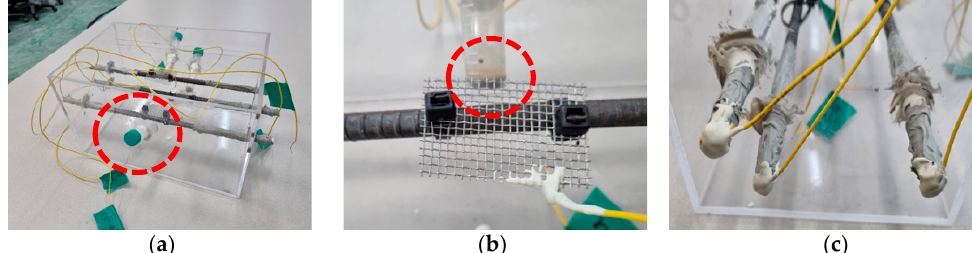
Figure 3. Reinforced concrete (RC) samples and wire connection for open-circuit potential (OCP) measurement. ( a ) Photo of RC samples; wire connection for ( b ) counter electrode (CE) and ( c ) working electrode (WE).